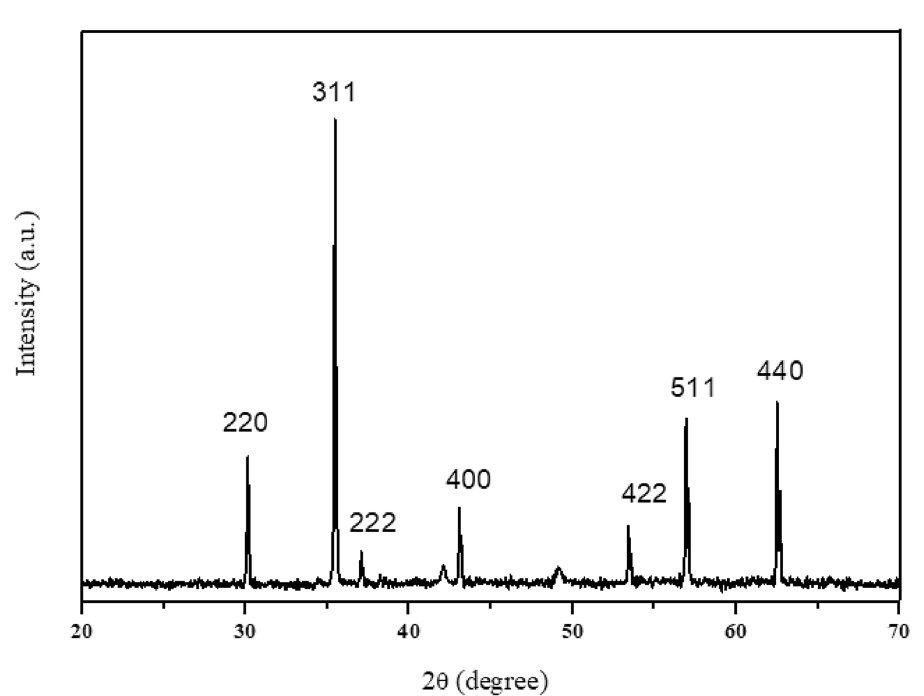
Figure 3. XRD pattern of nickel zinc ferrite (Ni 0.5 Zn 0.5 Fe 2 O 4 ) sintered at 1200